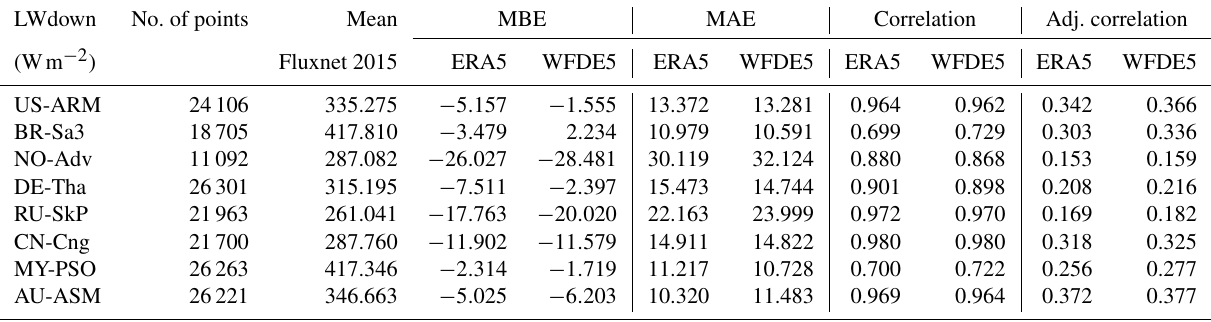
Table A6. LWdown metrics for each FLUXNET2015 site: ERA5 versus FN2015 and WFDE5 versus FN2015 at hourly time steps. LWdown